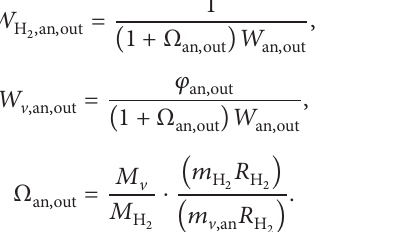
Figure 6. The development of practical online prediction